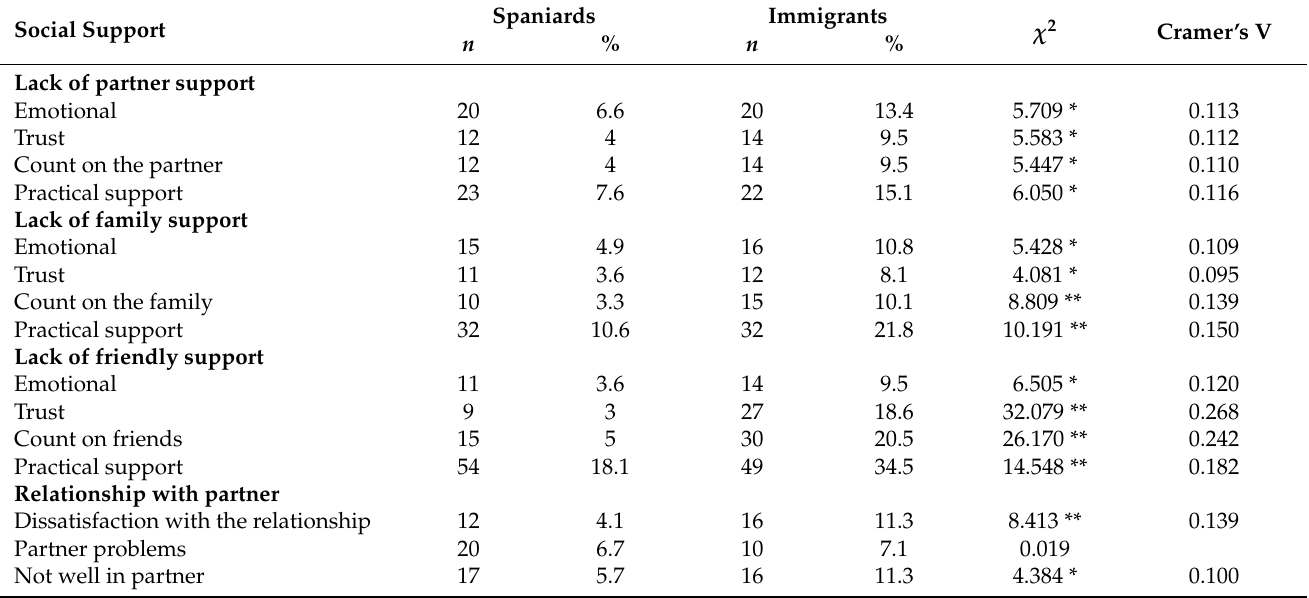
Table 4. Lack of social support according to